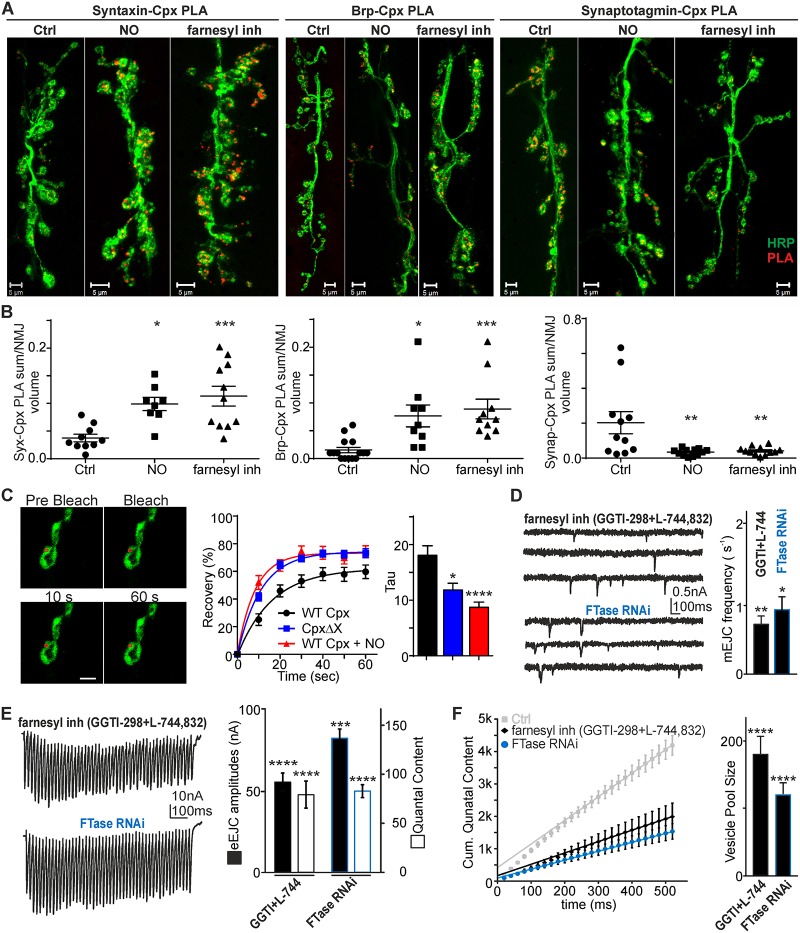
Reduced farnesylation of cpx enhances AZ localization and alters interactions with SNARE proteins.(A) Maximal projection confocal images of w1118 NMJs in Ctrl, following 60 min of exposure to NO or farnesylation inhibitor (“farnesyl inh”: 10 μM GGTI-298 + 20 μM L-744,832). PLA fluorescence in red and HRP staining in green for: left, syntaxin-cpx; middle: Brp-cpx; right: synaptotagmin-cpx interactions. (B) Analysis of summated PLA signal volumes relative to NMJ volumes. (C) FRAP experiments were performed at NMJs expressing GFP-cpx, shown as representative images of WT GFP-cpx at different time points (bleaching area: 2.5 μm2, scale bar: 2 μm). Right, mean data showing recovery of WT, CpxΔX, and NO-treated WT cpx, with mean tau values summarized. Note, lack of farnesylation due to the mutation or NO treatment results in faster recovery rates. (D) Representative mEJC recordings following 60 min incubation with GGTI-298 + L-744,832 (“farnesyl inh”) or of a larva expressing FTase-RNAi with mean mEJC frequencies. (E) Trains of 50-Hz stimulation of a larva incubated for 60 min with GGTI-298 + L-744,832 (“farnesyl inh”) or expressing FTase-RNAi with mean eEJC amplitudes and QC. (F) Cumulative QC of 50-Hz trains with mean estimated RRP sizes (right). The raw data can be found in S7 Data. Data denote mean ± SEM, Student t test, or ANOVA with post hoc Tukey-Kramer as indicated, *p < 0.05, **p < 0.01, ***p < 0.001, ****p < 0.0001. AZ, active zone; Brp, Bruchpilot; cpx, complexin; Ctrl; control; eEJC, evoked EJC; EJC, excitatory junction current; FRAP, fluorescence recovery after photobleaching; FTase, farnesyl transferase; GFP, green fluorescent protein; HRP, horseradish peroxidase; mEJC, miniature EJC; NMJ, neuromuscular junction; NO, nitric oxide; PLA, proximity ligation assay; QC, quantal content; RNAi, RNA interference; RRP, readily releasable pool; SNARE, soluble N-ethyl-maleimide-sensitive fusion protein Attachment Protein Receptor; WT, wild-type.